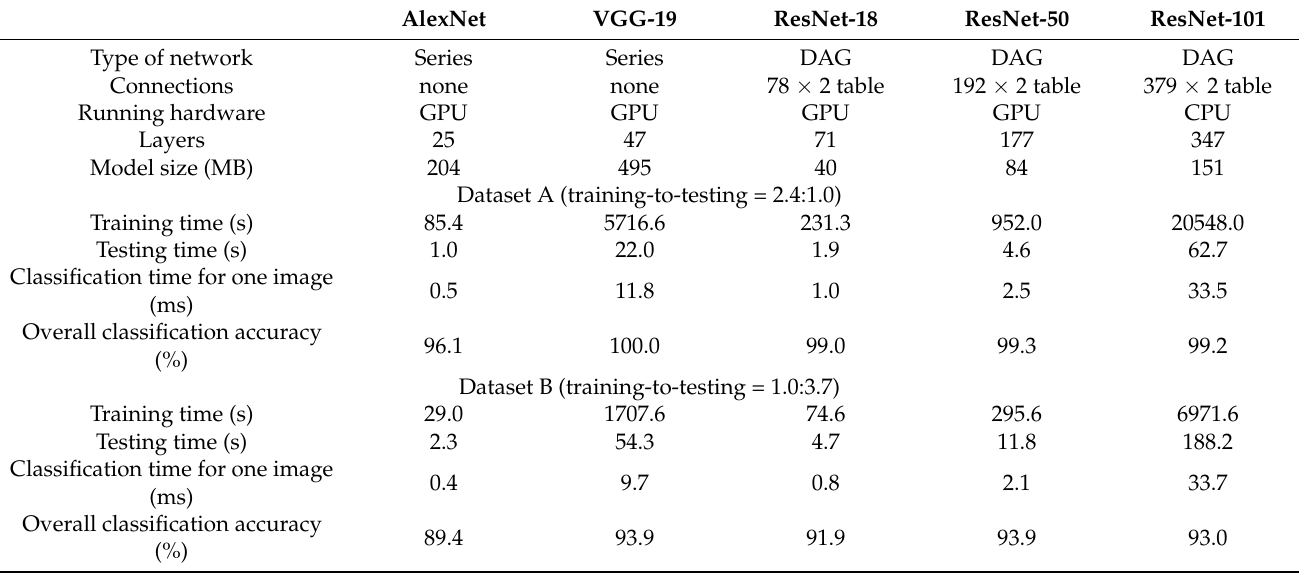
Table 2. Comparison of the different trained models.